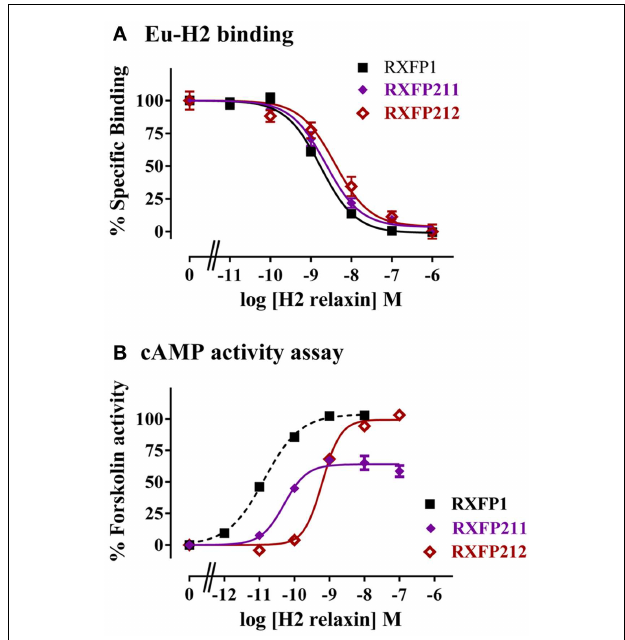
FIGURE 4 |Activity of RXFP1 chimeric receptors compared to RXFP1 . (A) Competition binding using Eu-labeled H2 relaxin. (B) H2 relaxin-induced cAMP responses. cAMP activity is expressed as the percentage of the 5 µ M Forskolin-stimulated response for each receptor. Note the data for the RXFP211 receptor has been normalized for cell surface expression (see text for details). Data are expressed as mean ± SEM of triplicate determinations from at least three independent